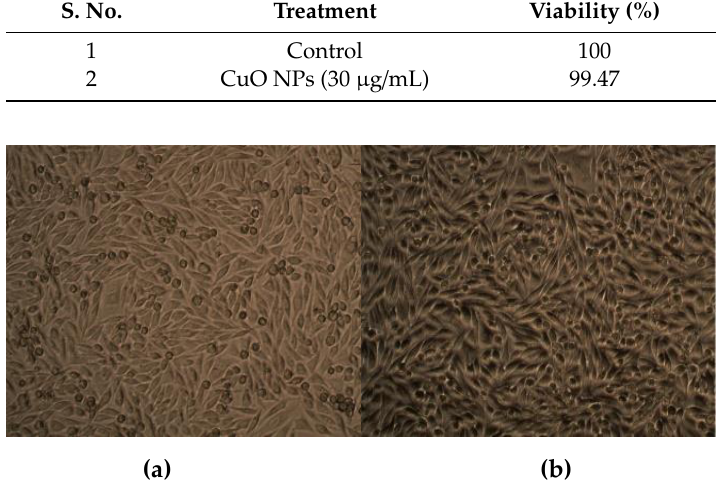
Table 5. Impact of CuO NPs on viability of human dermal fibroblast cells.